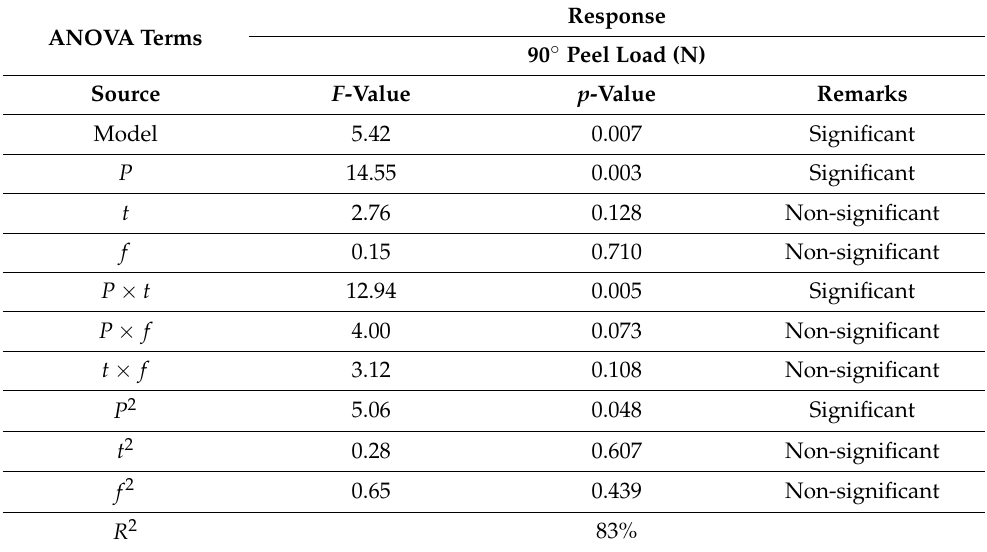
Table 5. ANOVA for the fitted quadratic model for response. ANOVA